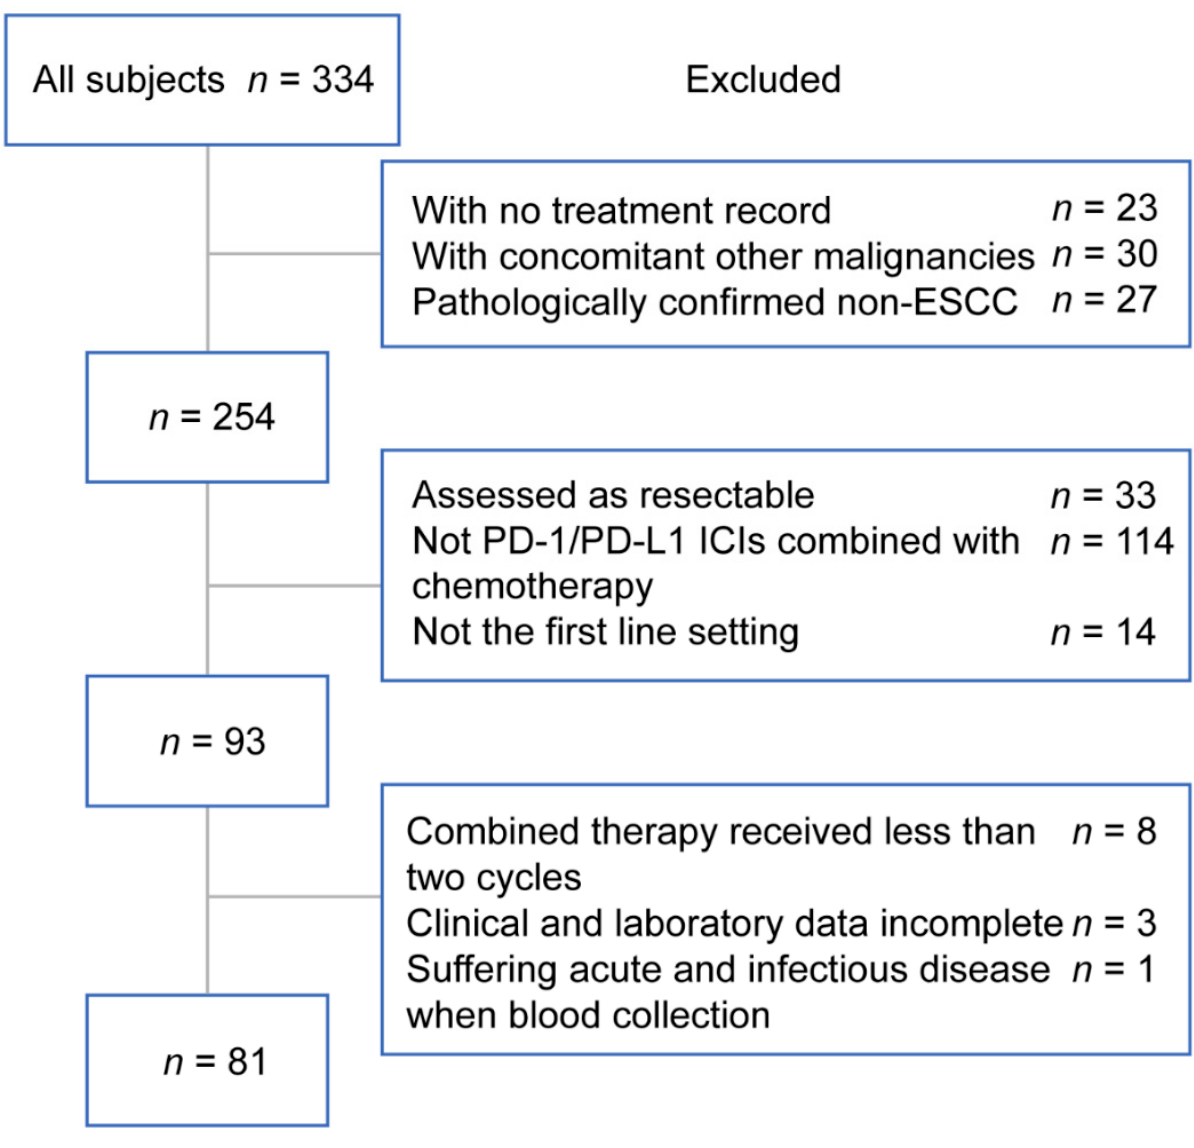
Figure 1. The flowchart presented the screening process for eligible patients. Abbreviations: PD-1, programmed death-1; PD-L1, programmed death ligand-1; ICIs, immune checkpoint inhibitors.